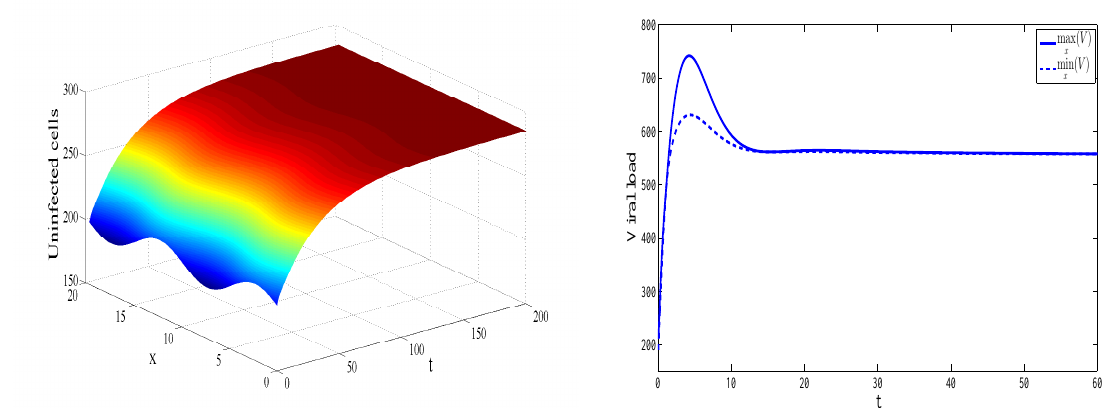
Figure 3. Dynamics of solution for λ = 10, d 1 = 0.0139, k 1 = 0.04, d 2 = 0.0495, k 2 = 1.1, d 3 = 0.5776 , a = 100, d 4 = 0.6, p = 0.0024, c = 0.15, and b = 0.5. The concentration of uninfected cells is shown as a function of x and t ( left ). The maximal and the minimal value of the virus concentration with respect to x are shown as functions of time ( right